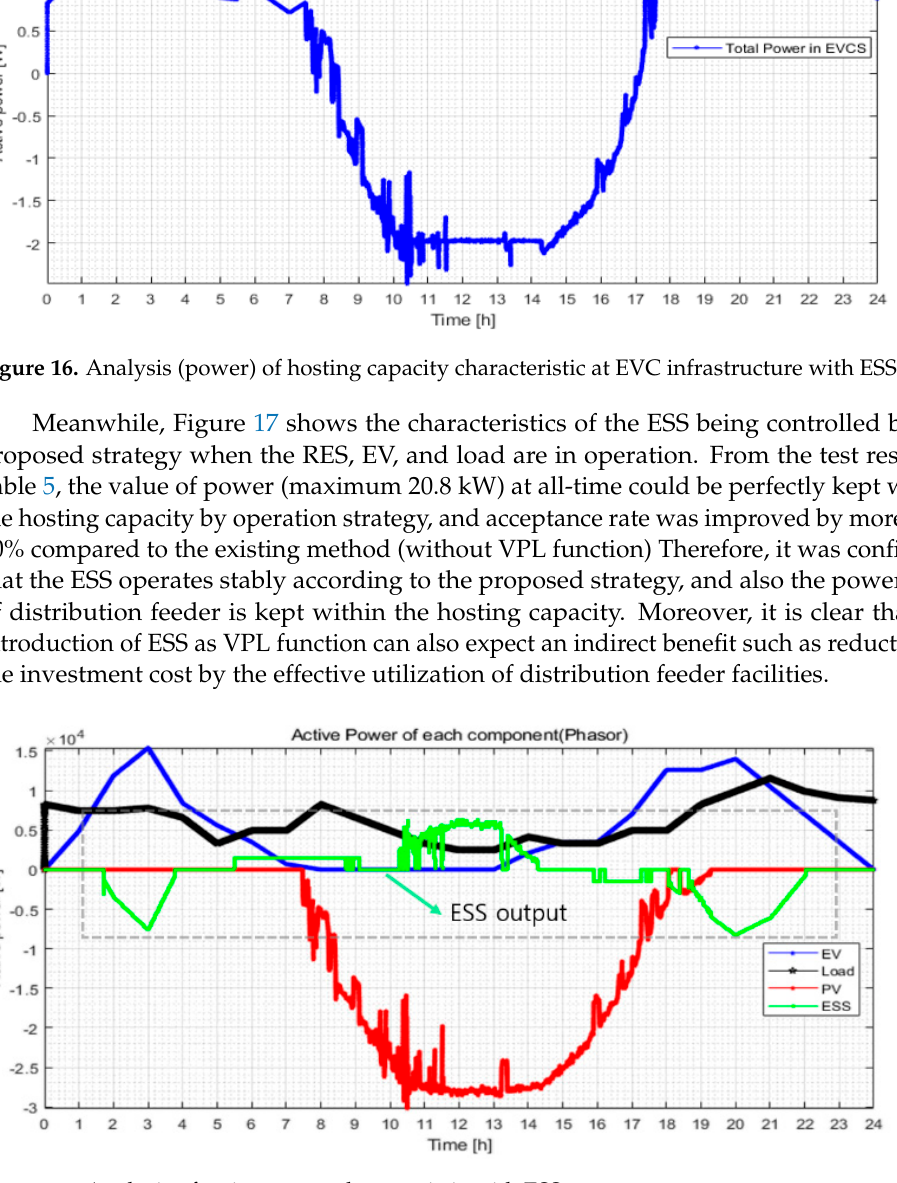
Figure 17. Analysis of active power characteristic with ESS. Table 5. Results of hosting capacity ( 𝑳𝑭 𝒉𝒐𝒔𝒕𝒊𝒏𝒈 ) of VPL.